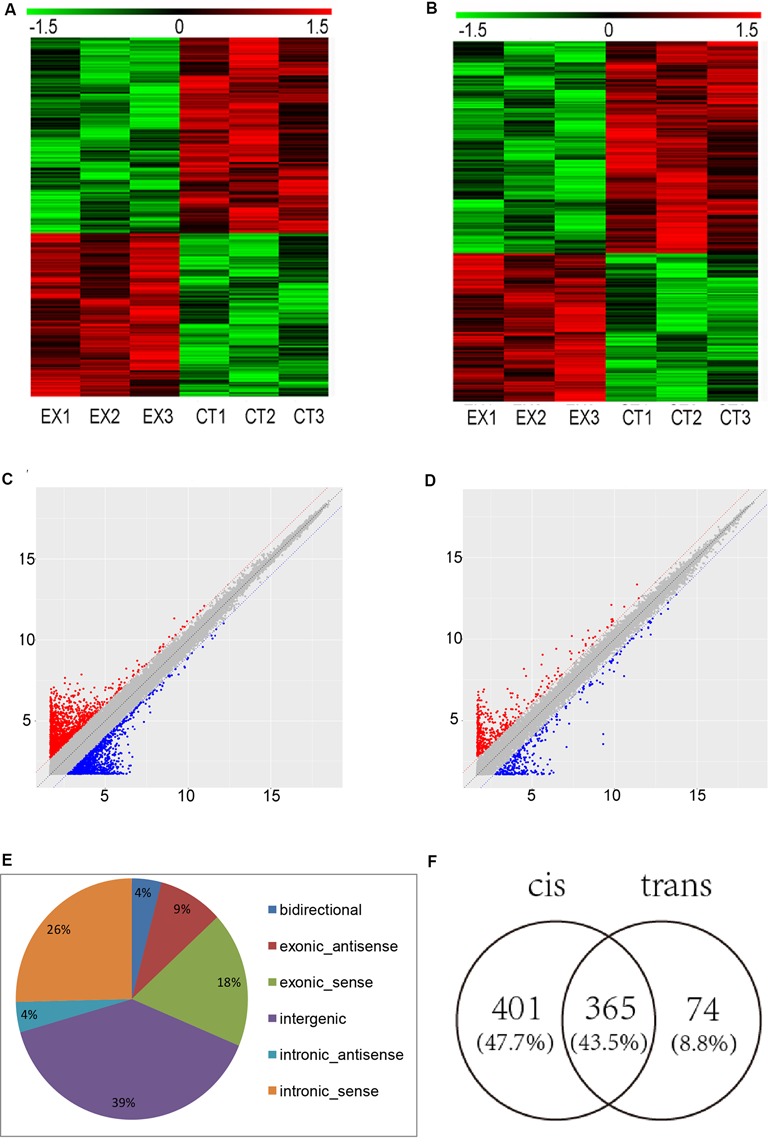
Microarray analysis for long non-coding RNAs (lncRNAs) and mRNAs expression in the brains of mice infected with T. gondii Chinese1 Wh 6 strain. (A) Hierarchical clustering of differentially expressed lncRNAs in the brain of mice infected and uninfected with T. gondii. Values in the color scale are normalized intensities. Red bands indicate high relative expression and green bands indicate low relative expression. (B) Hierarchical clustering of differentially expressed mRNAs in the brain of mice infected and uninfected with T. gondii. Values in the color scale are normalized intensities. Red bands indicate high relative expression and green bands indicate low relative expression. (C) Volcano Scatter plot filtering was used to visualize fold regulation and statistical significance in lncRNA populations in mice brains. Statistically significant (p ≤ 0.05) up (red) or down (blue) regulated expression changes (>2-fold) are shown in pair-wise comparisons of T. gondii infected and uninfected mice brains. (D) Volcano Scatter plot filtering was used to visualize fold regulation and statistical significance in mRNAs populations in mice brains. Statistically significant (p-value ≤ 0.05) up (red) or down (blue) regulated expression changes (>2-fold) are shown in pair-wise comparisons of T. gondii infected and uninfected mice brains. (E) Classification of dysregulated lncRNAs in the brain of mice infected by T. gondii. (F) Venn diagram of the target genes of dysregulated lncRNAs using cis and trans analysis.